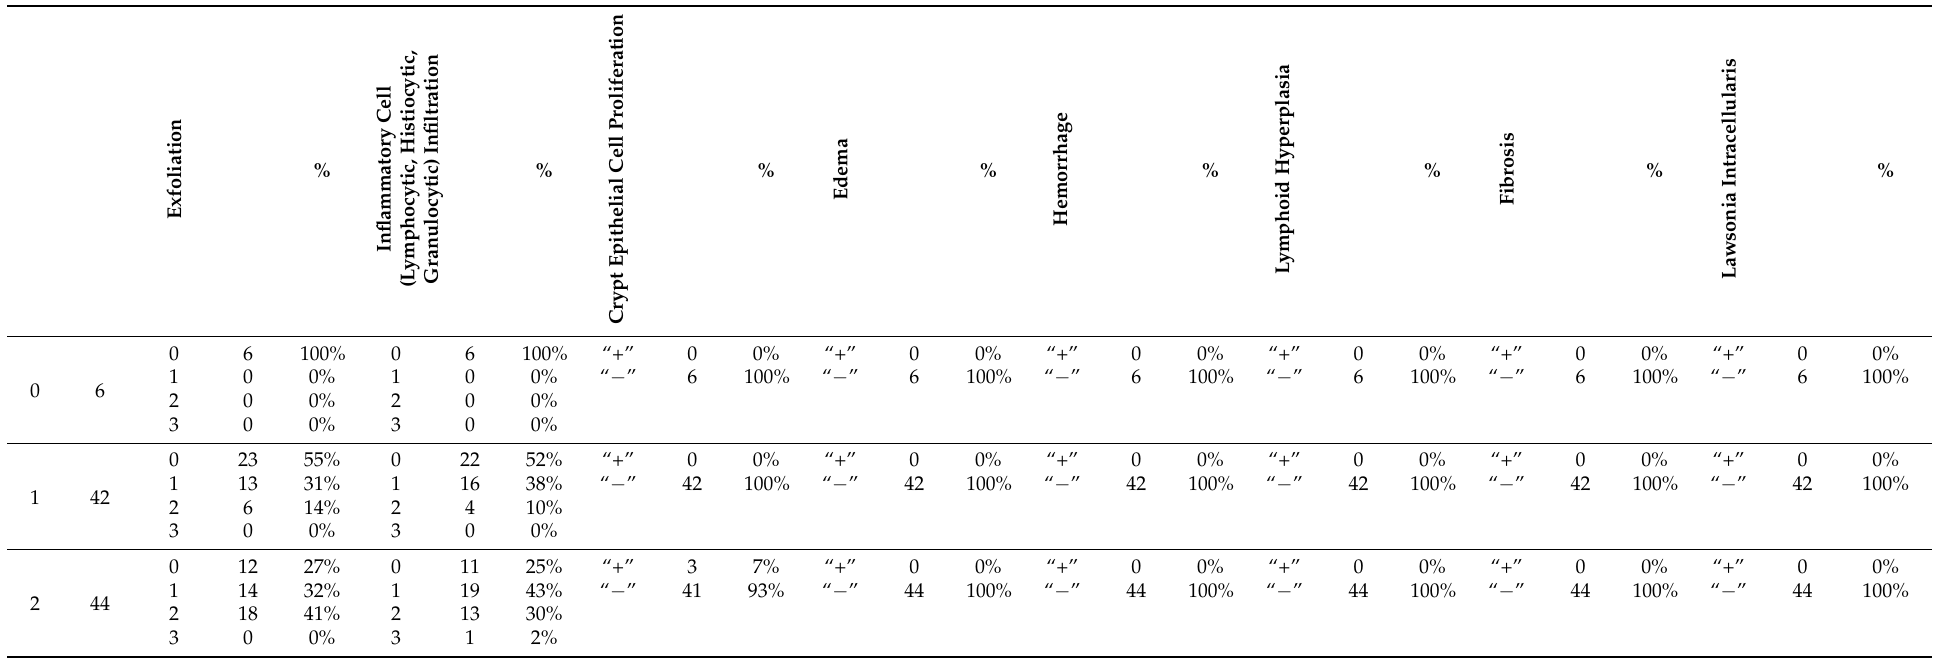
Table 6. VP versus Histopathology and